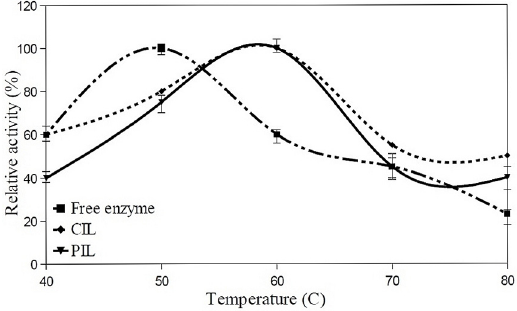
Figure 5: Thermal stability of the free and immobilized lipase at 50 °C for different time intervals (0-8 h).